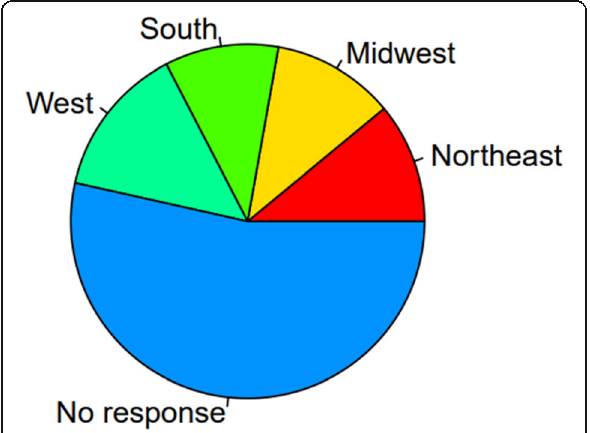
Fig. 3 Distribution of hookah “ ever use ” in the USA, from the National Adult Tobacco Survey (NATS) 2012 – 2013 ( n = 60,192)